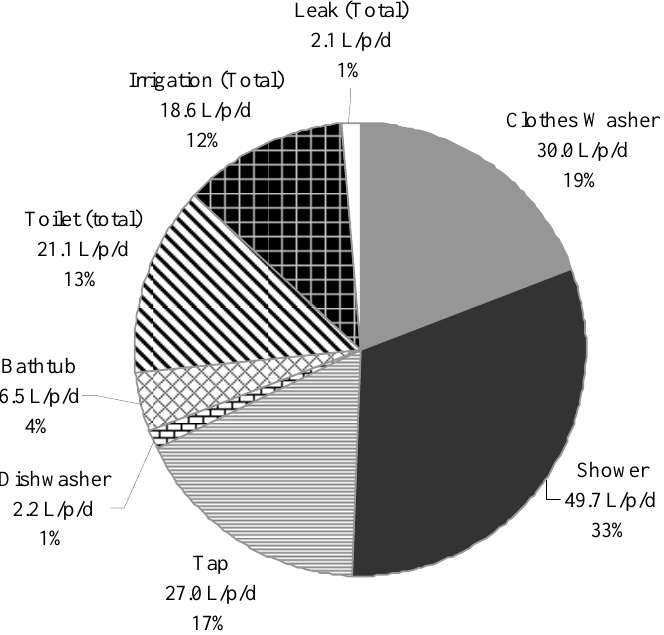
Figure 2. End use breakdown, Gold Coast (winter pre-retro fit) [6].